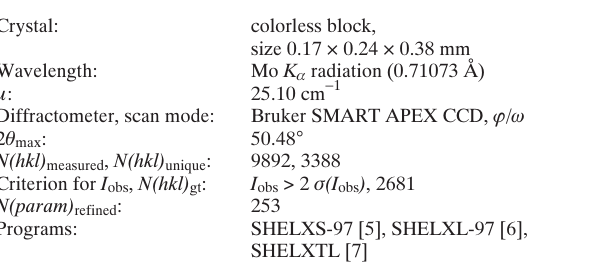
Table 1. Datacollection and handling.